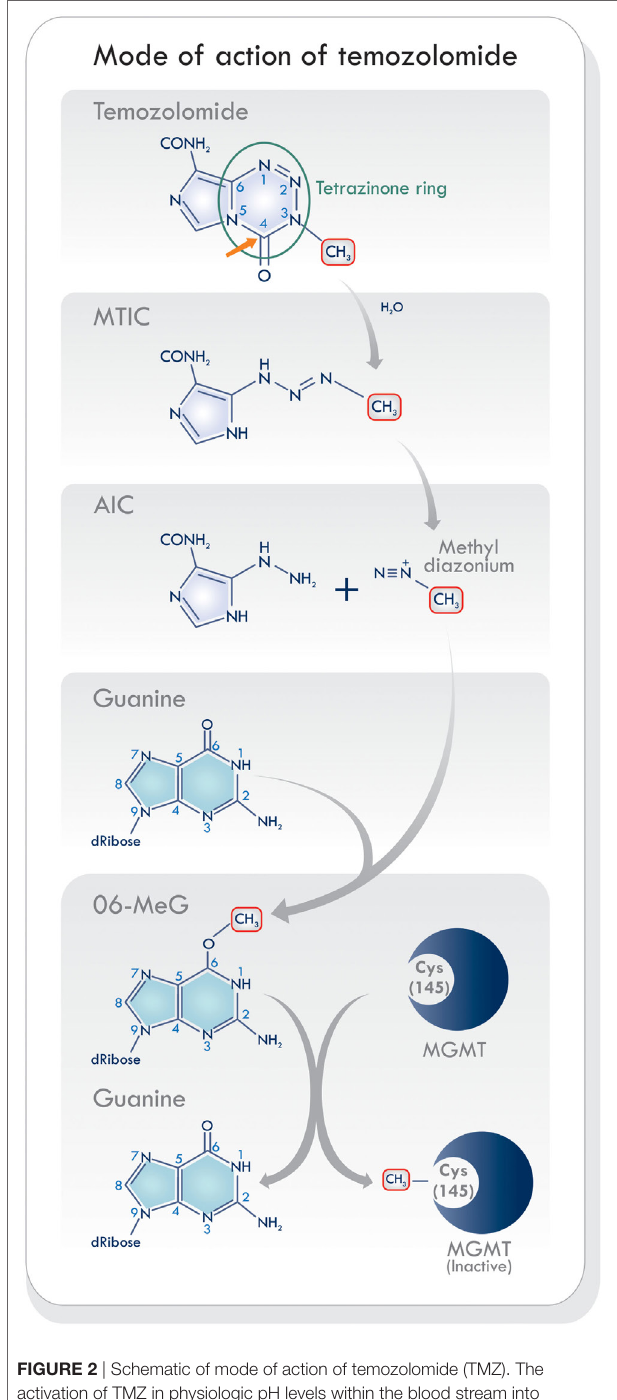
FiGURe 2 | Schematic of mode of action of temozolomide (TMZ). The activation of TMZ in physiologic pH levels within the blood stream into its reactive state that is responsible for methylating DNA. Based on Ref. (8, 19, 23). Abbreviations: MTIC, 5-(3-monomethyl-1-triazeno) imidazole-4-carboxamide; AIC, 5-aminoimidazole-4-carboxamide; MGMT, O6-methylguanine-DNA